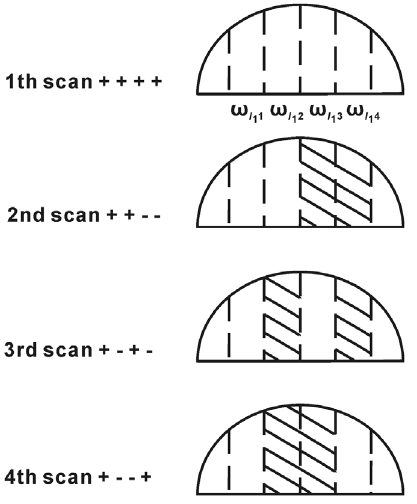
Figure 2. Encoding diagram (Scan times=4), reproduced according to literature [ 24 ]